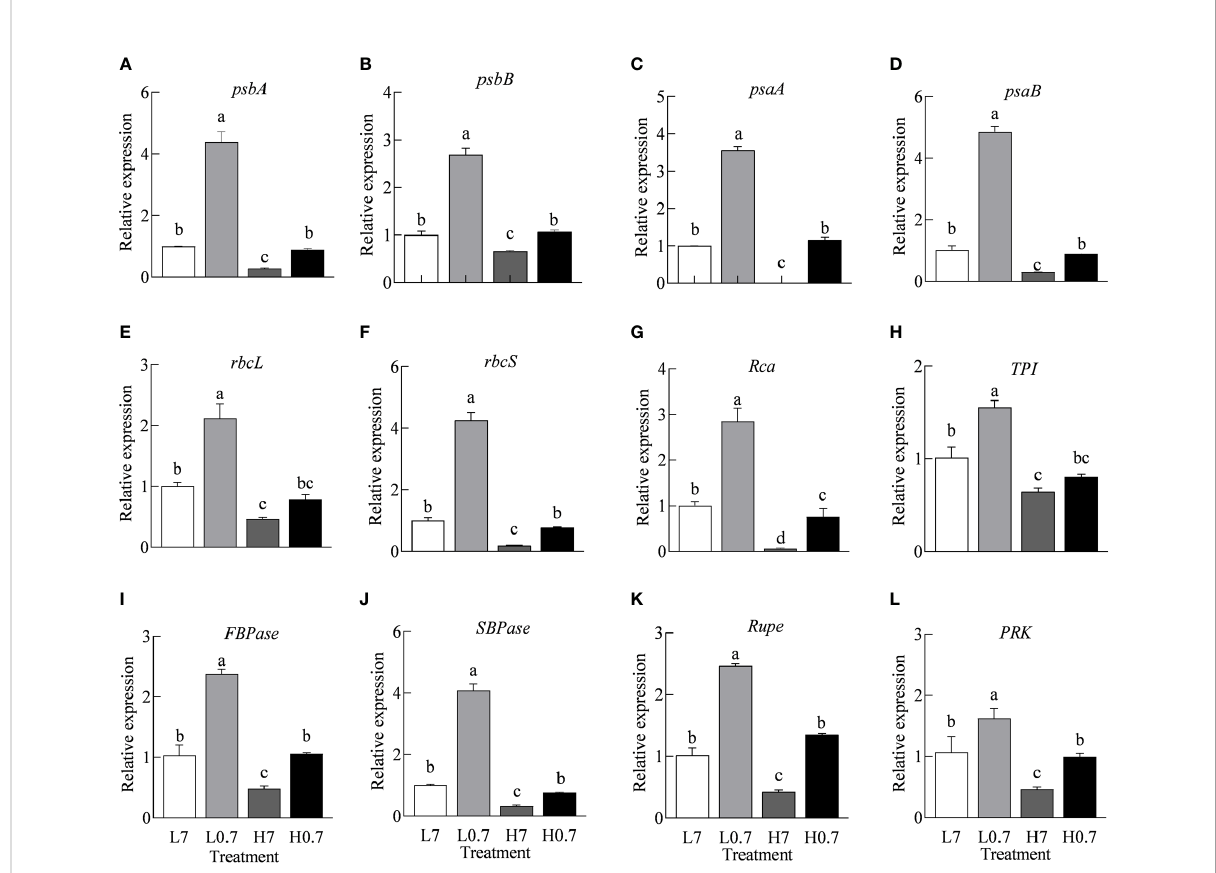
FIGURE 6 Effect of R/FR on relative expression levels of key genes involved in electron transport and Calvin cycle in cucumber leaves under salt stress. The relative expression levels of psbA (A) , psbB (B) , psaA (C) and psaB (D) genes involved in electron transport and relative expression levels of rbcL (E) , rbcS (F) , Rca (G) , TPI (H) , FBPase (I) , SBPase (J) , Rupe (K) and PRK (L) genes involved in Calvin cycle rbcL , ribulose-1,5-bisphosphate carboxylase/oxygenase large subunit; rbcS , ribulose-1,5-bisphosphate carboxylase/oxygenase small subunit; Rca , ribulose-1,5-bisphosphate carboxylase/oxygenase activase; TPI , propanosyl phosphate isomerase; FBPase , fructose-1,6-bisphosphatase; SBPase , scenic heptulose-1,7- bisphosphatase; Rupe , ribulose-5-phosphate epimerase; PRK , ribulose-5-phosphate kinase. Different letters indicate signi fi cant differences (P< 0.05; n=